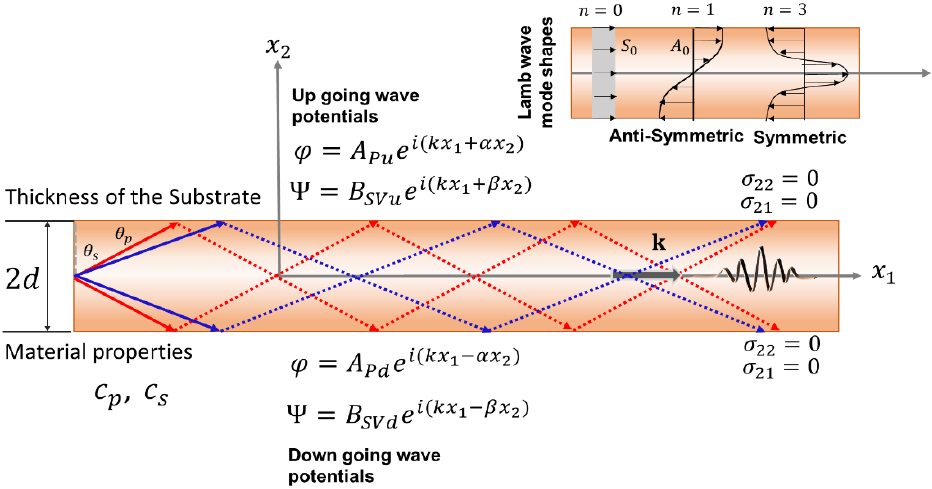
Figure 5. Schematic of the Lamb waves propagating through a substrate. Mathematical equations are those used in deriving the Lamb wave dispersion [91].